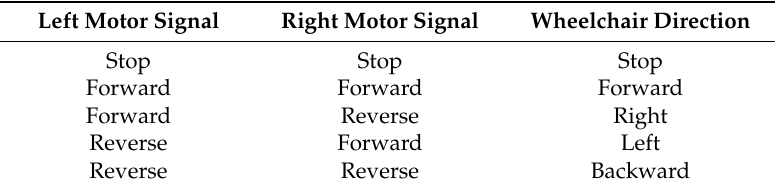
Table 1. Wheelchair direction of motion based on left and right motor signals produced by the simulation.